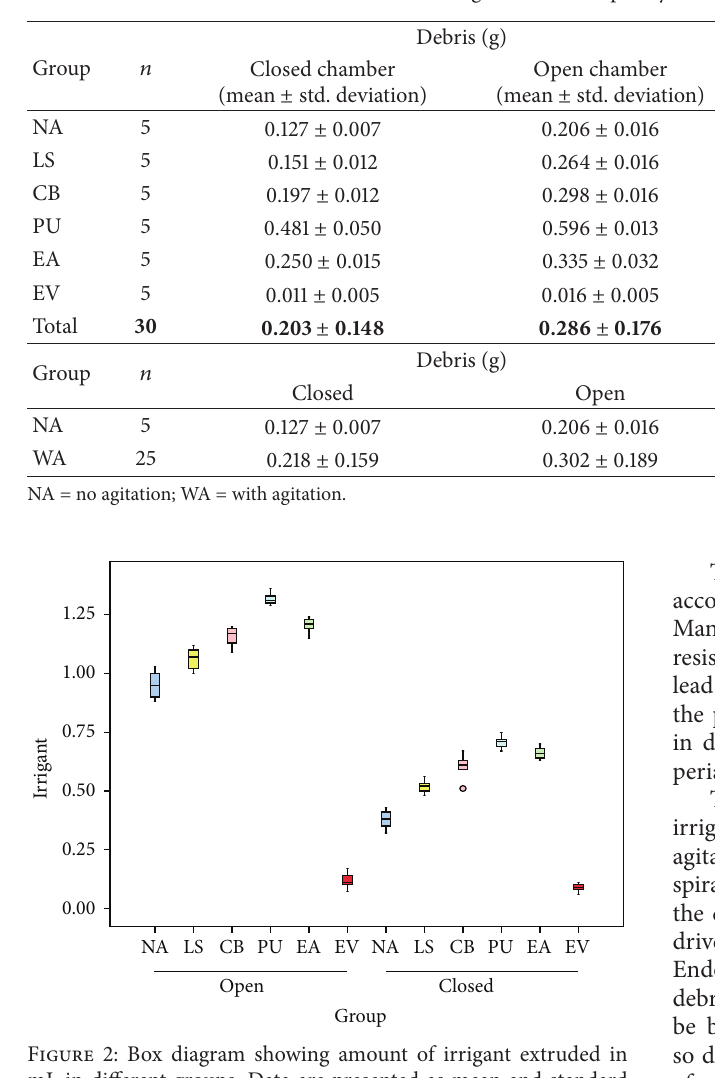
Table 1: Amount of debris and irrigant extruded apically in different study groups open and closed chambers.